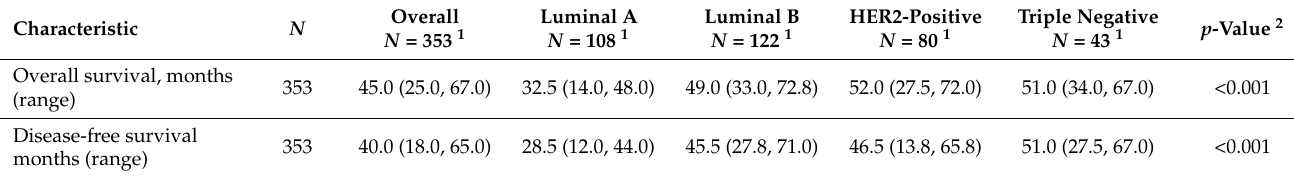
Table 1. Patient characteristics by cancer subtypes (clinical